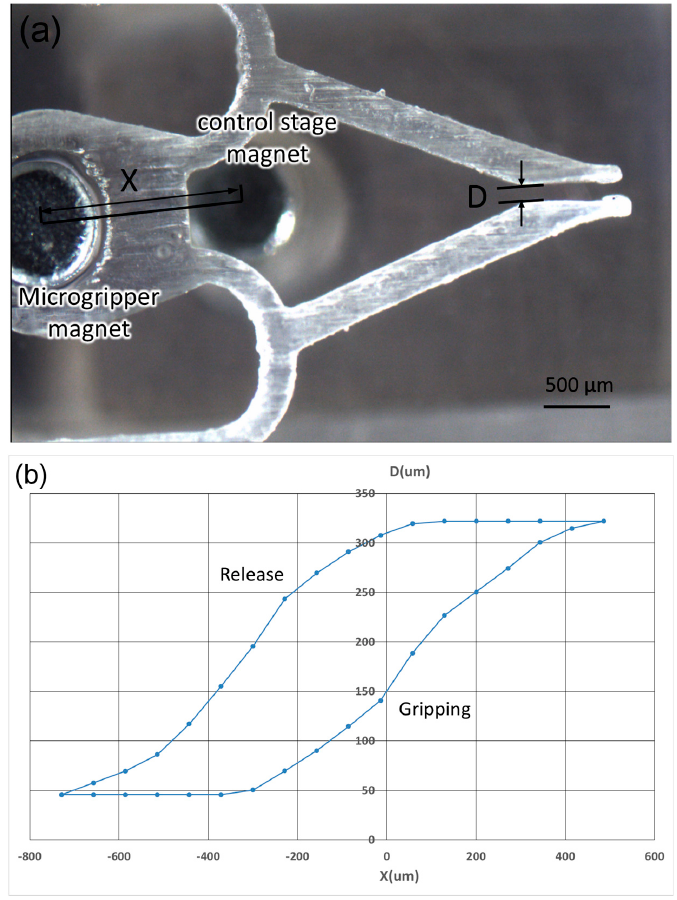
Figure 7. Relationship between magnet movement and the gap between the two thin beams of the microgripper. ( a ) An illustration of the experiment. The distance between the two magnets fixed to the microgripper and control stage is x; D is the gap in the gripper. ( b ) The relationship between the moving of the magnet x and the size of the gripper opening D.